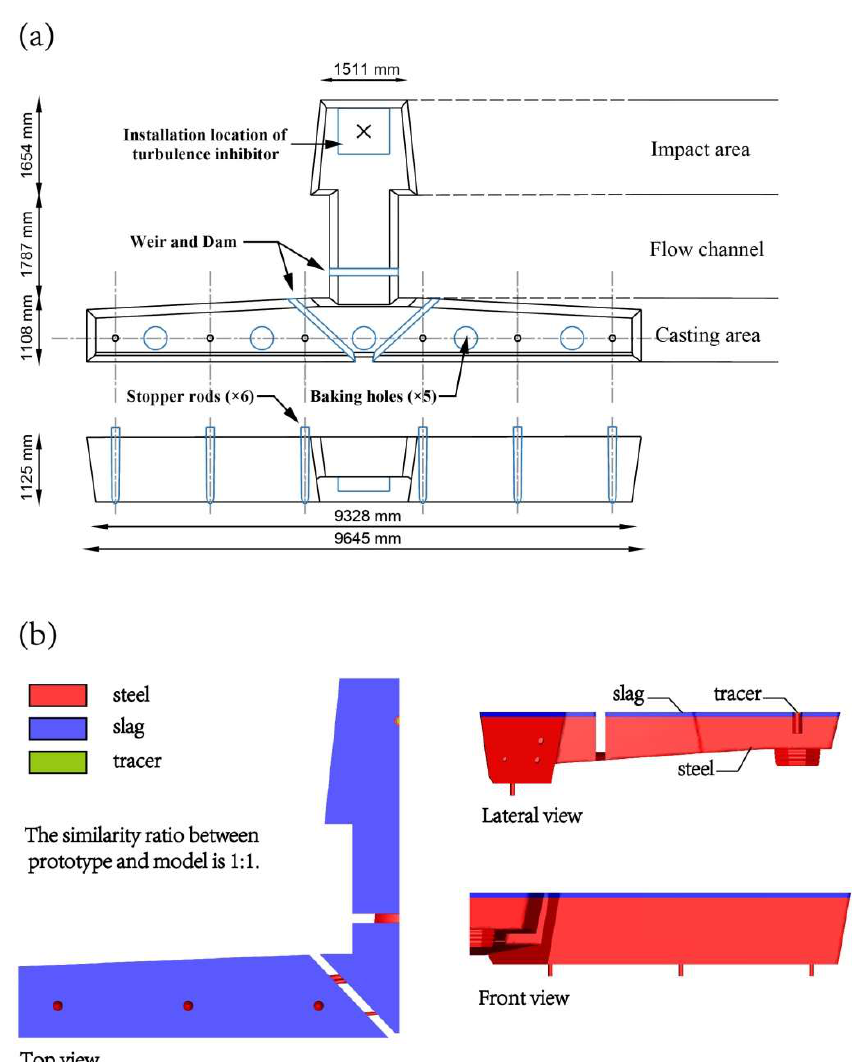
Figure 2. Schematic diagram of ( a ) field prototype tundish structure and ( b ) numerical simulation tundish structure at 800 s.